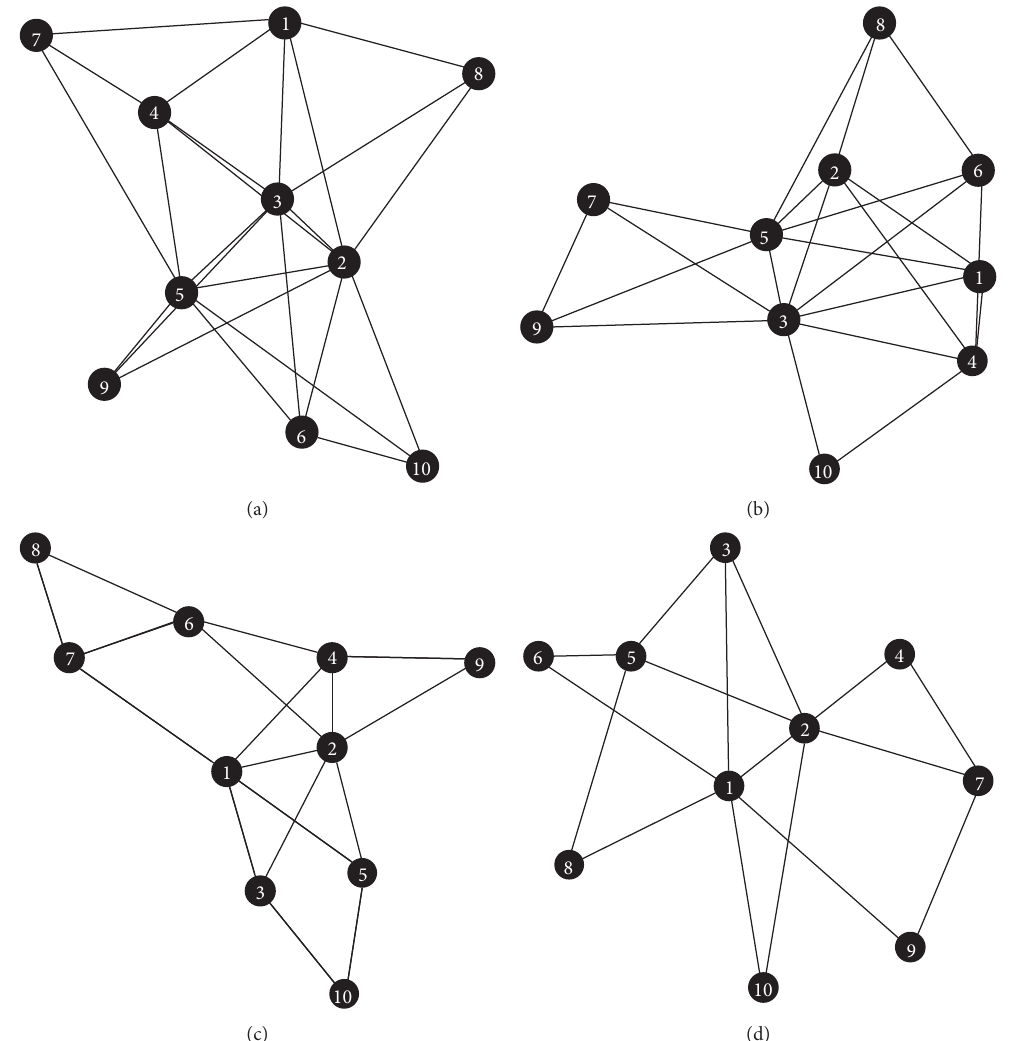
Figure 2: The topology structures of the response (a, b) and drive (c, d) network. (a) A R , (b) B R , (c) A D , (d) B D